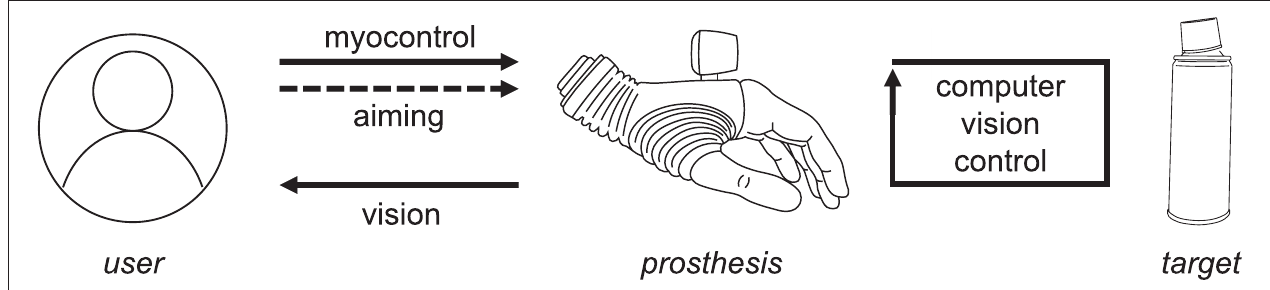
FIGURE 1 | A semi-autonomous control strategy. The user orients the prosthesis to aim at the target. The prosthesis responds continuously to objects identified as the target, and the subject uses visual assessment and interpretation of the prosthesis motion to adjust the aiming.